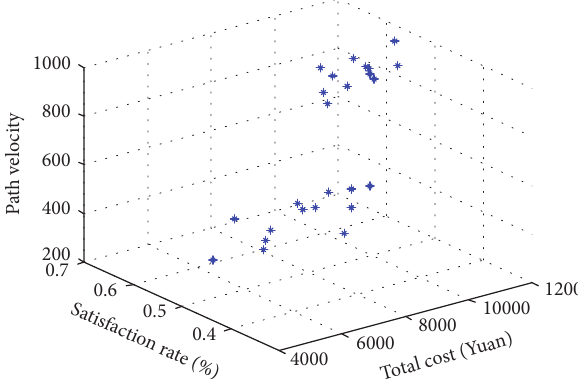
Figure 1: Obtained by genetic algorithm